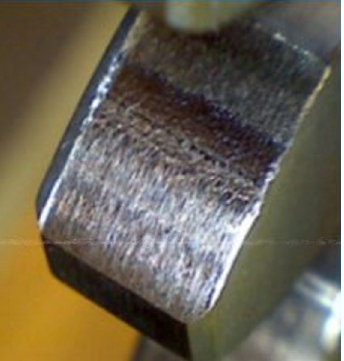
Fig. 17 Sample scuffed